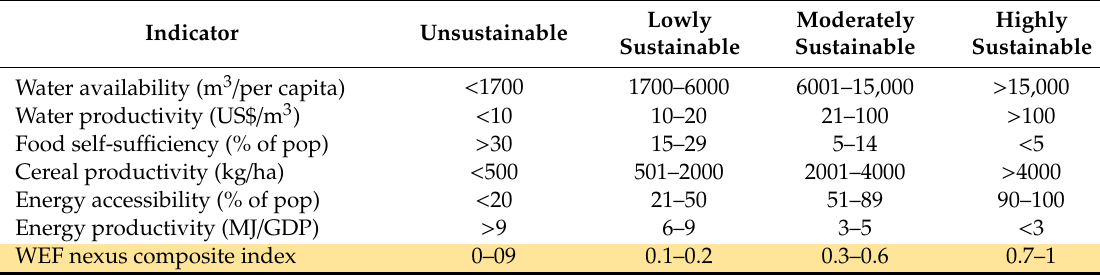
Table 5. WEF nexus indicators performance classification